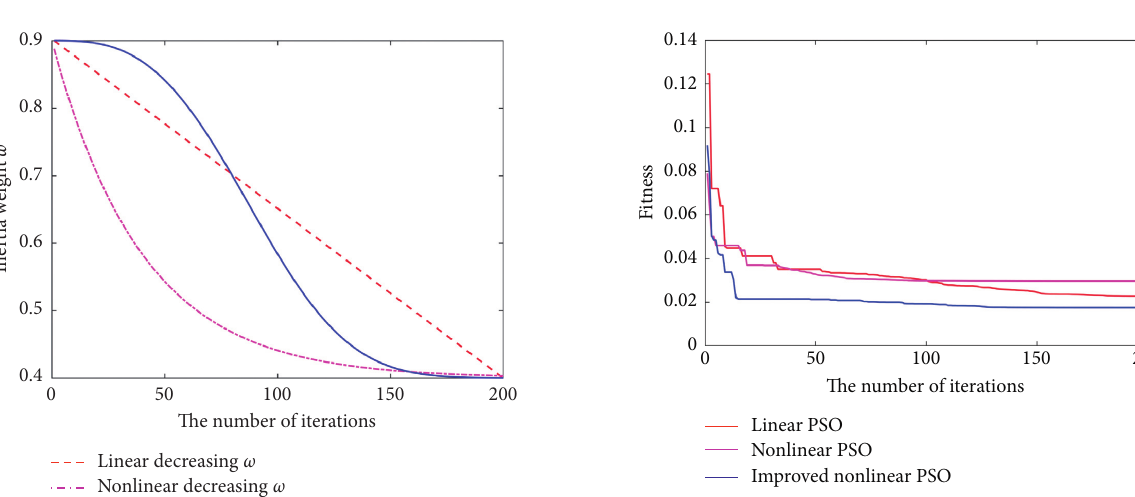
Figure 6: Comparison fitness curve of three PSO